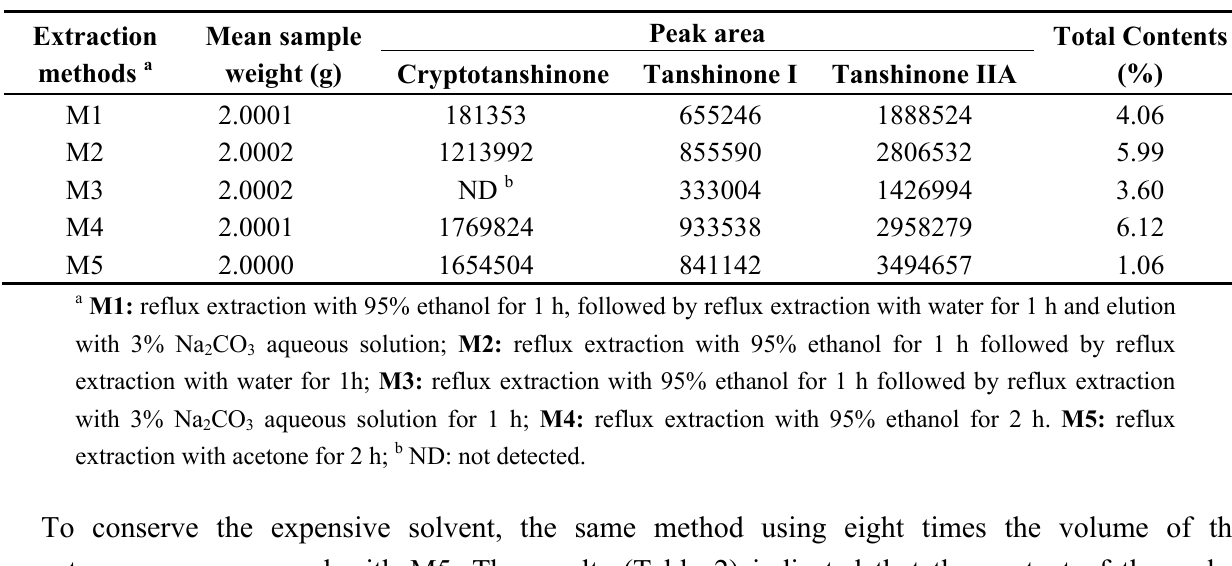
Table 1. Comparison of extraction methods (n =